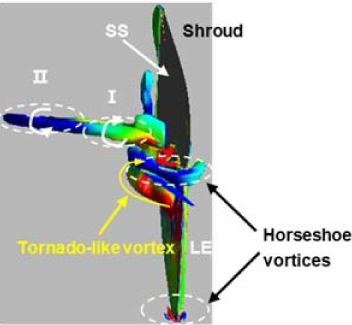
Figure 13. Detailed vortex structures at TVD vane leading-edge ( ϕ = 0.7 Q d ).